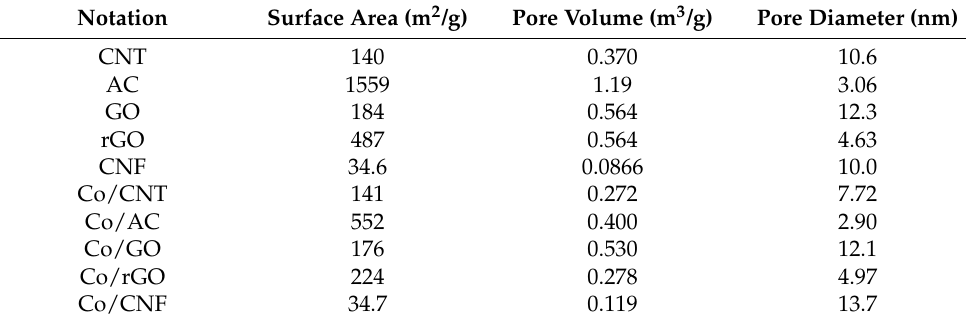
Table 2. Surface Area, Pore Volume, and Pore